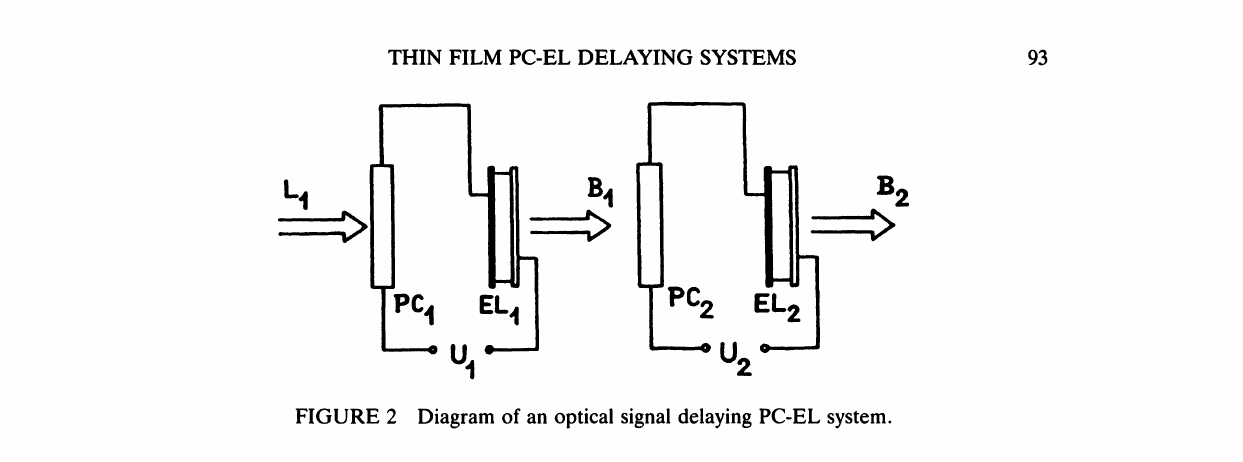
FIGURE 2 Diagram of an optical signal delaying PC-EL